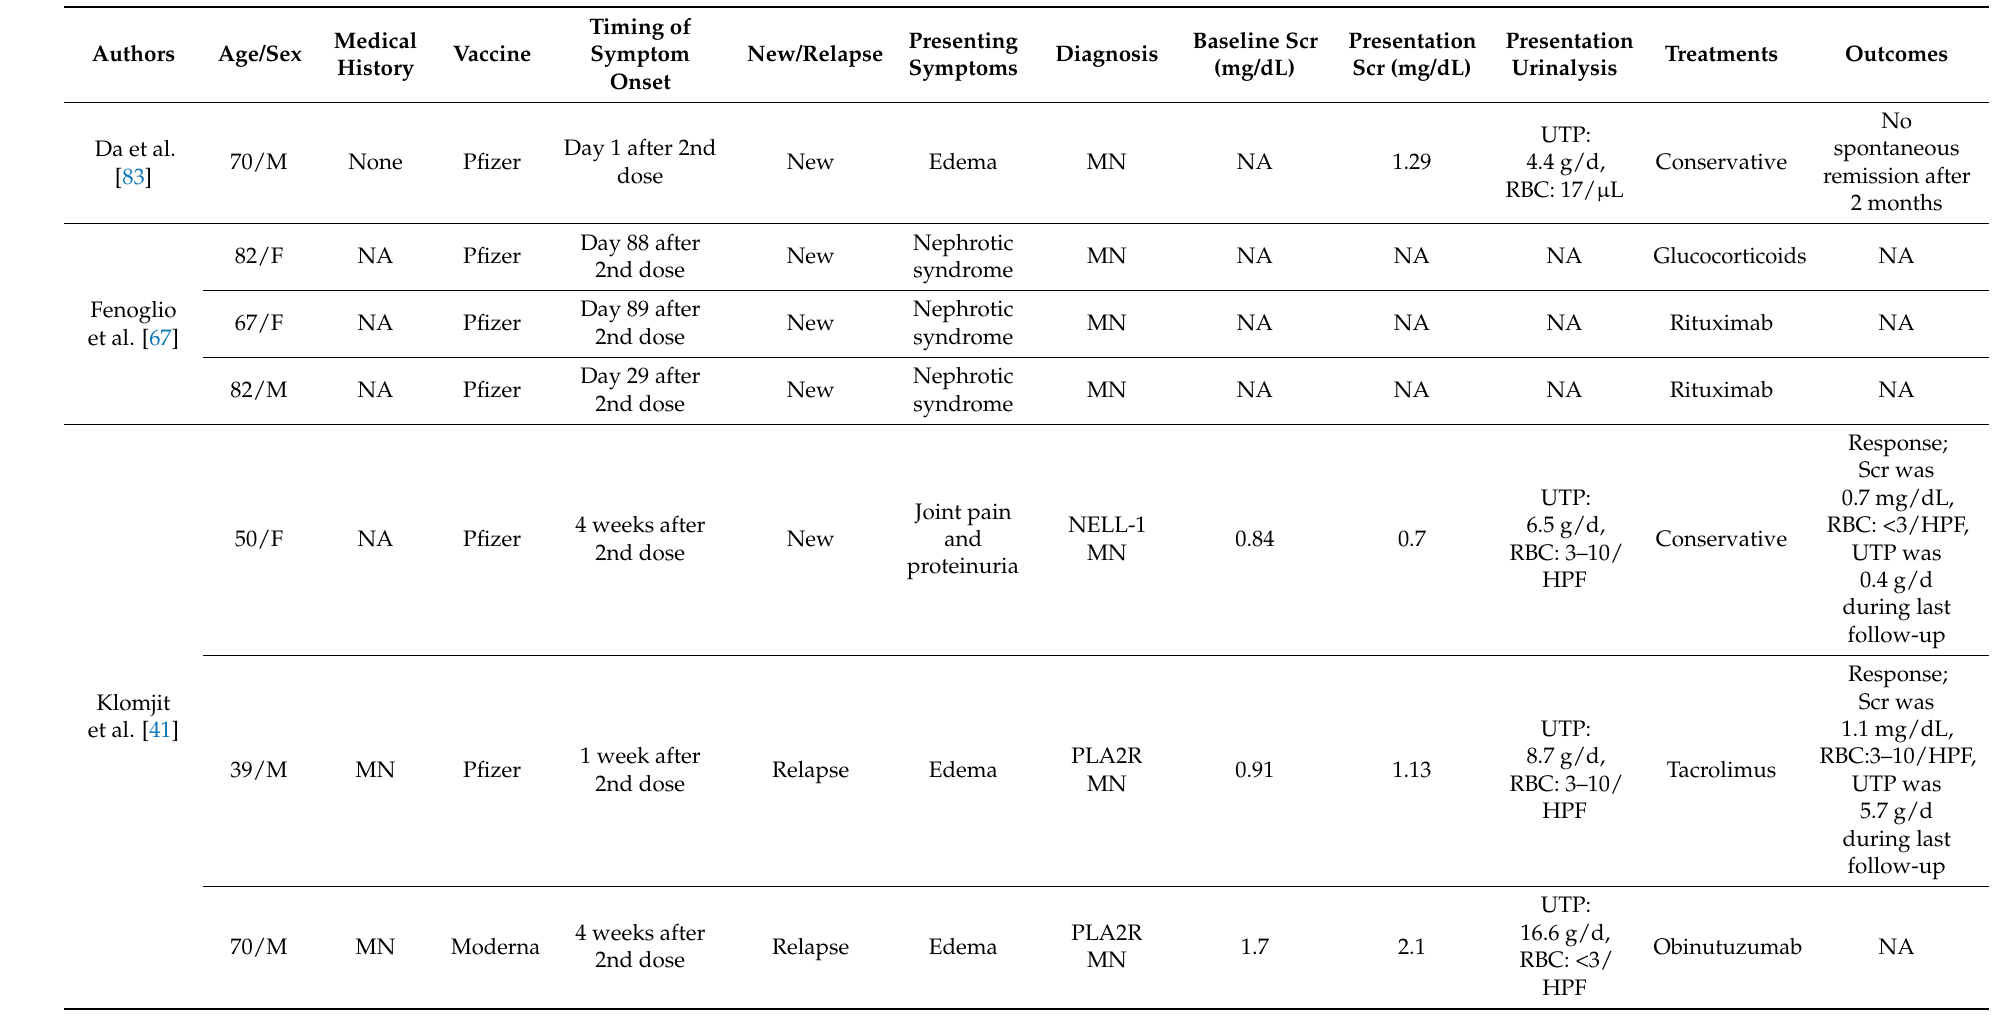
Table 2. Summary of other cases of renal side effects following COVID-19